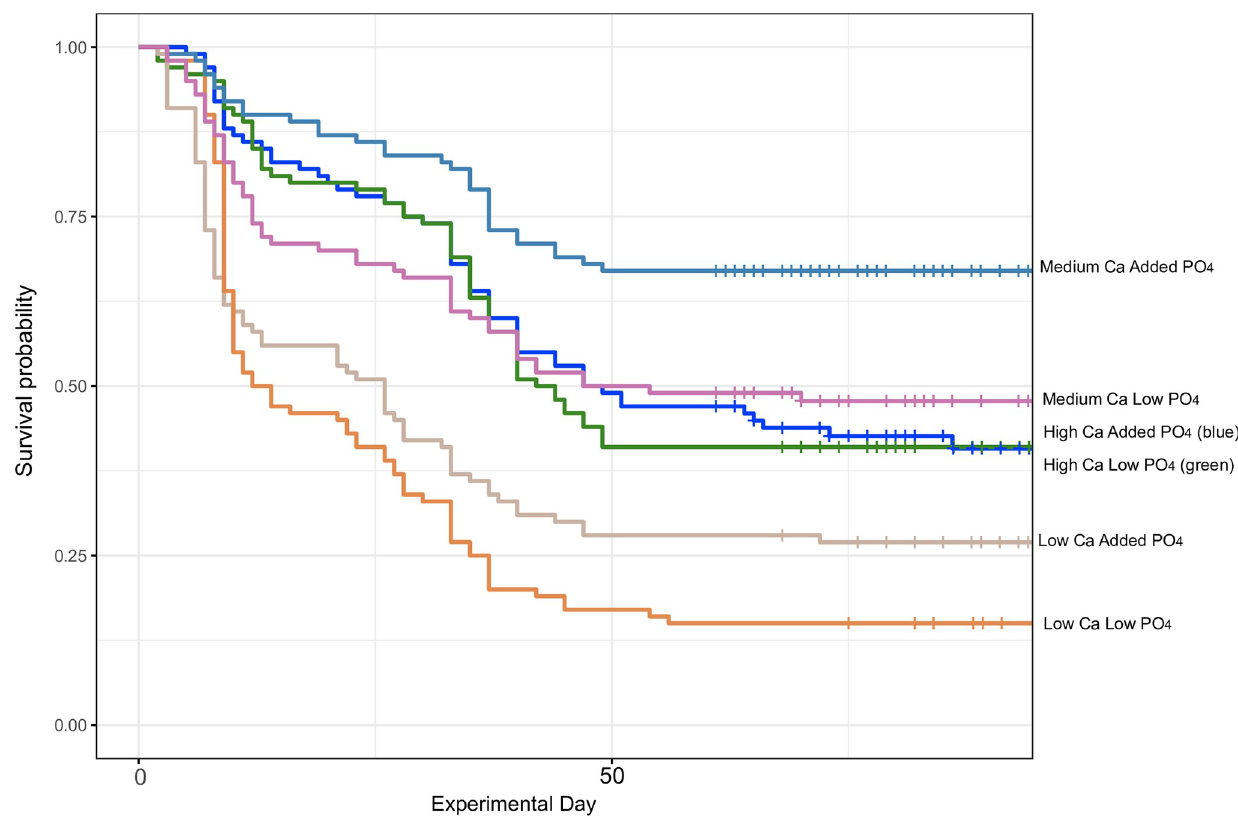
Fig 3. Survival probability curves for the 6 experimental treatment groups, cross hatches indicate censored animal(s) that metamorphosed and were censored from this survivorship analysis at that point. A log-rank test (Table 3) revealed highly significant differences between groups, Chisq = 94 on 5 degrees of freedom, p = <